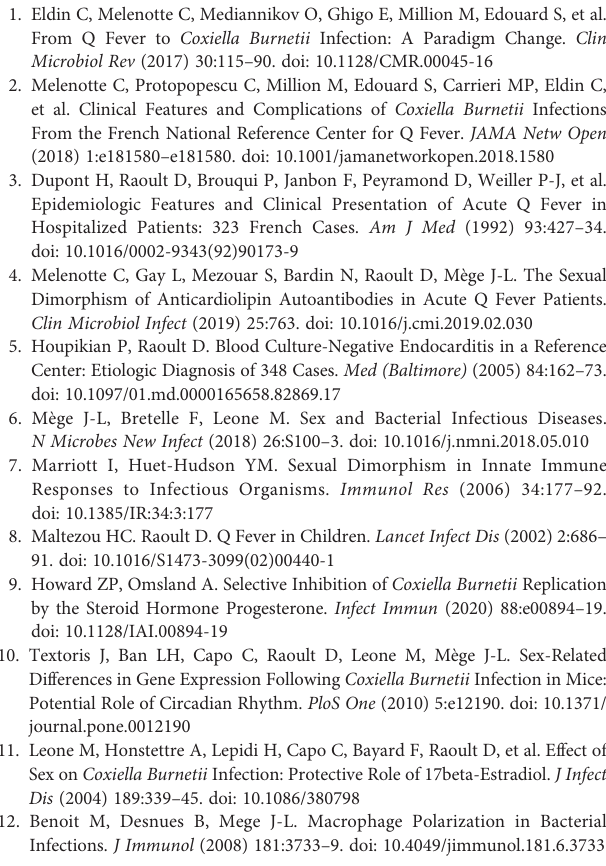
Supplementary Figure 4 | Effect of testosterone on the immunoregulatory response of LPS-stimulated MDMs. MDMs from males (n=8) were pre-treated with